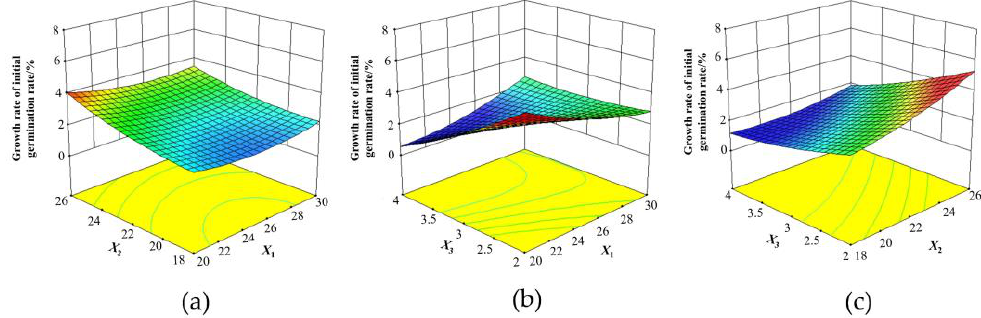
Figure 5. Growth rate of initial germination rate versus: ( a ) moisture content of Cyperus esculentus at the beginning of tempering and tempering temperature; ( b ) tempering duration and tempering temperature; ( c ) tempering duration and moisture content of Cyperus esculentus at the beginning of tempering.